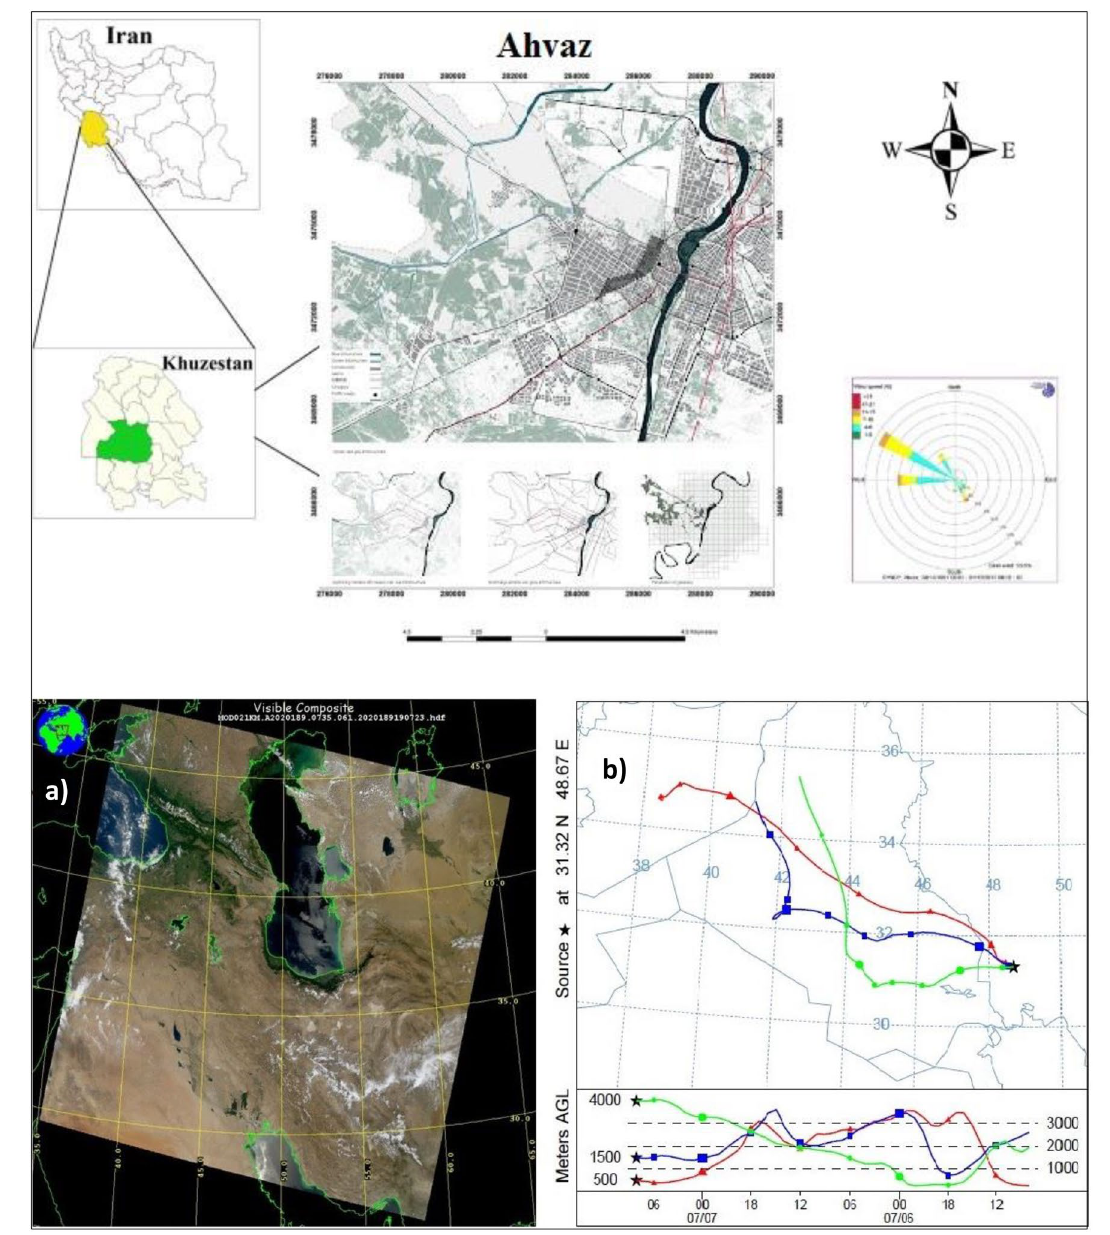
Fig. 1 The location of study area, a MODIS of Ahvaz over a Middle Eastern dust storms on summer 2021 and b backward trajectory of particu- late